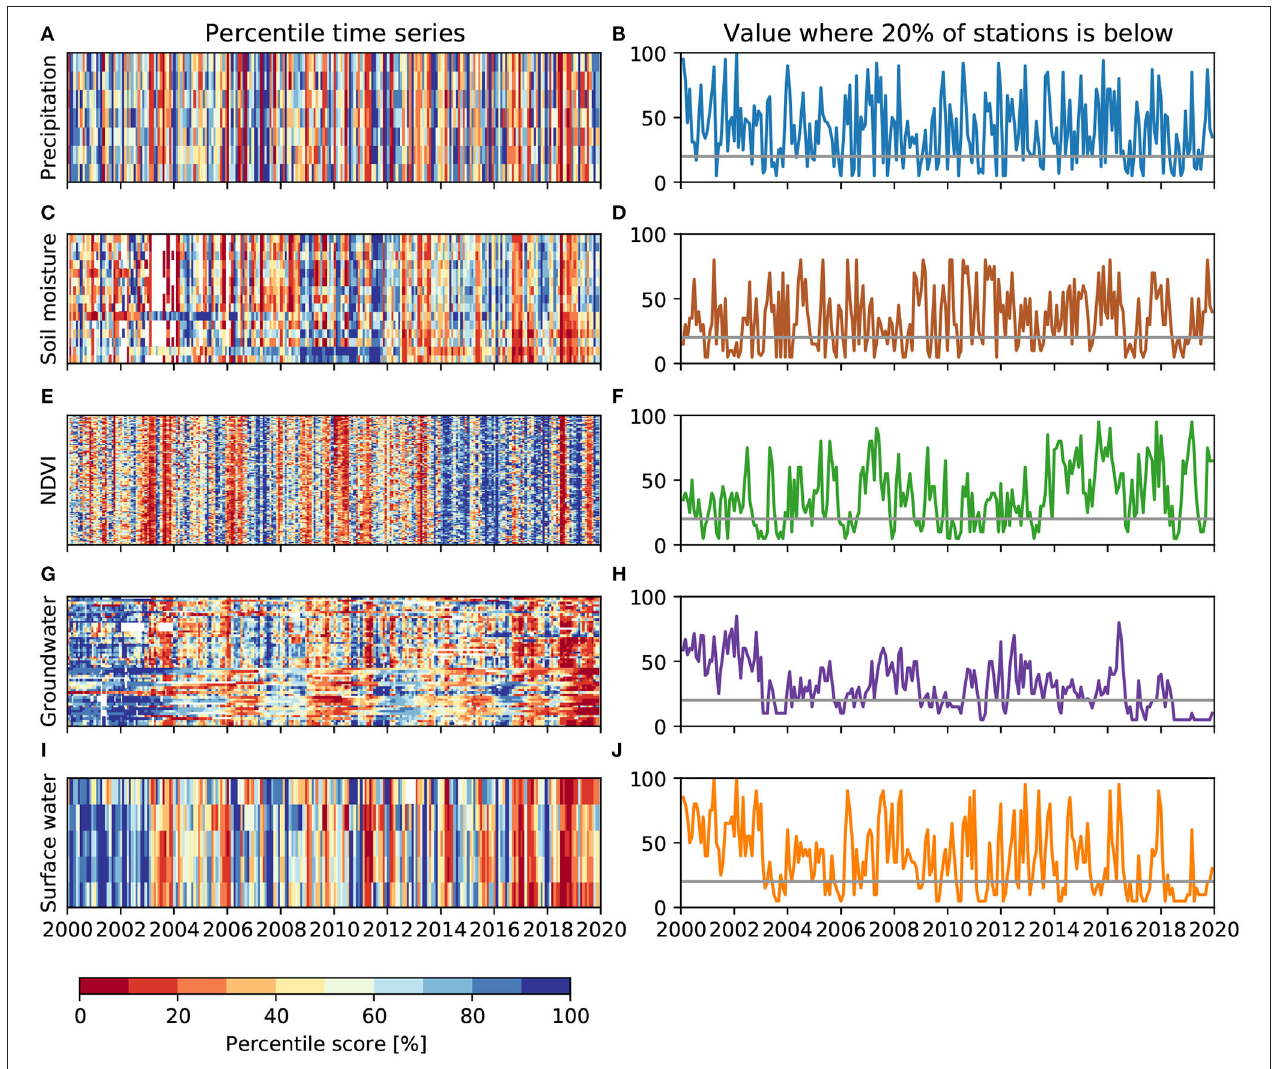
FIGURE 5 | Spatial and temporal variability in percentile scores across all variables. (A,C,E,G,I) Show the time series of all stations over the entire data period, where each row in each panel represents an individual measurement point/pixel. (B,D,F,H,J) Show the value that represents the point where 20% of the stations/pixels in that variable are below this